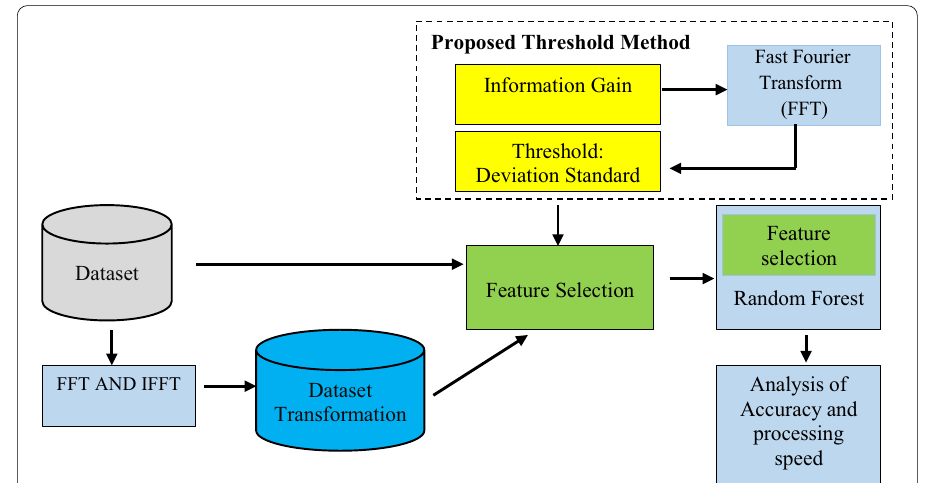
Fig. 1 The Overall Architecture of Feature